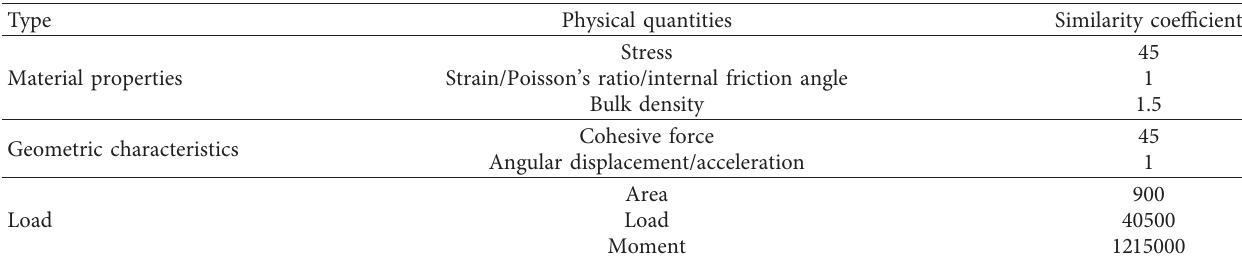
Table 6: Similarity ratio of other relevant physical quantities.